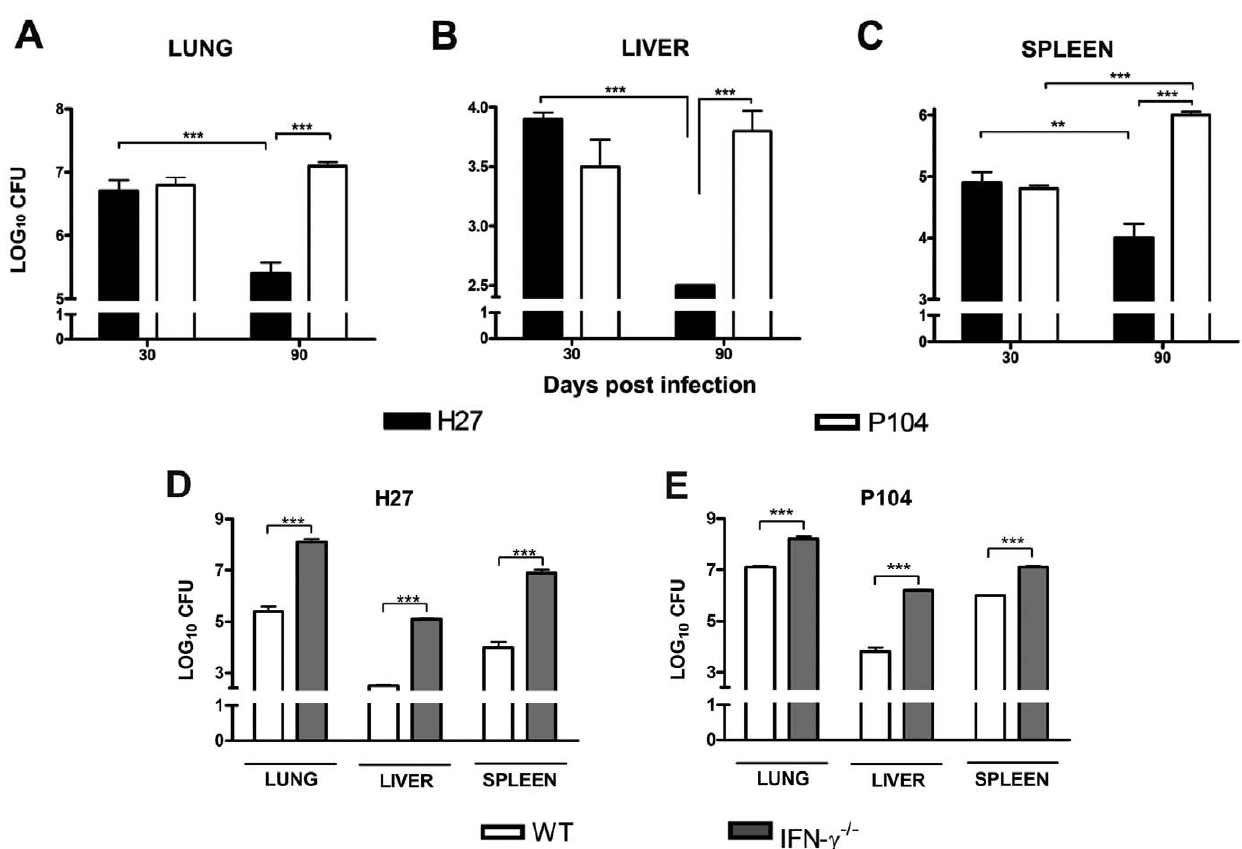
Figure 3. Comparison of lung, liver and spleen bacillary loads in C57BL/6 WT and GKO mice infected with M.avium strains. Mice were infected as indicated in the legend to Fig. 2. At the indicated time-points, six mice were sacrificed, and bacterial burdens (CFU) in the lungs, livers and spleens were measured. The data were obtained in two independent experiments. Asterisks represent statistical significance (**p , 0.01, ***p , 0.001).